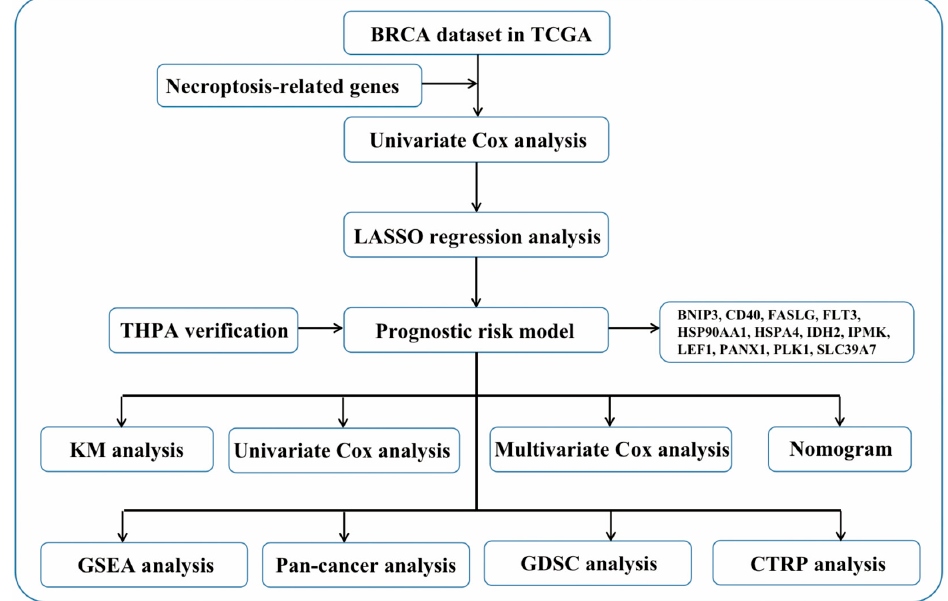
Figure 1. The flow chart of this